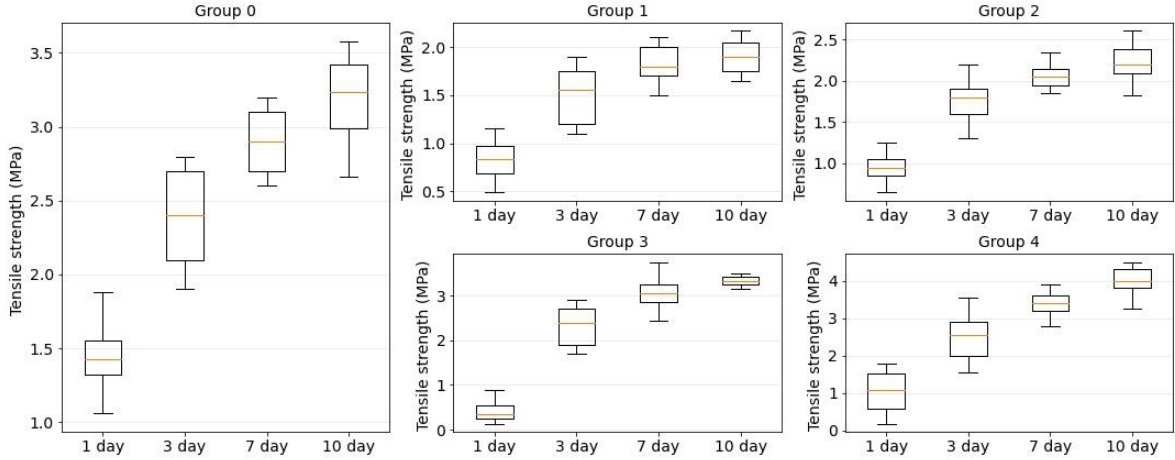
Figure 9. Tensile strength diagrams for traditional suture (group 0) and laser welds with BSA (group 1), BSA+ICG (group 2), BSA+SWCNT (group 3) and BSA+ICG+SWCNT (group 4) on 1, 3, 7, 10 postoperative days.